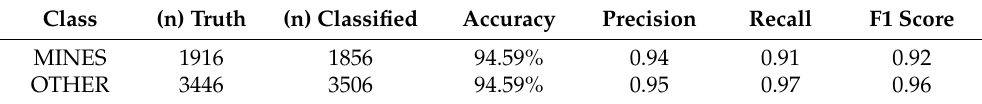
Table 3. Metrics per class in the model for the Vegetation Monitoring Device (VMD).